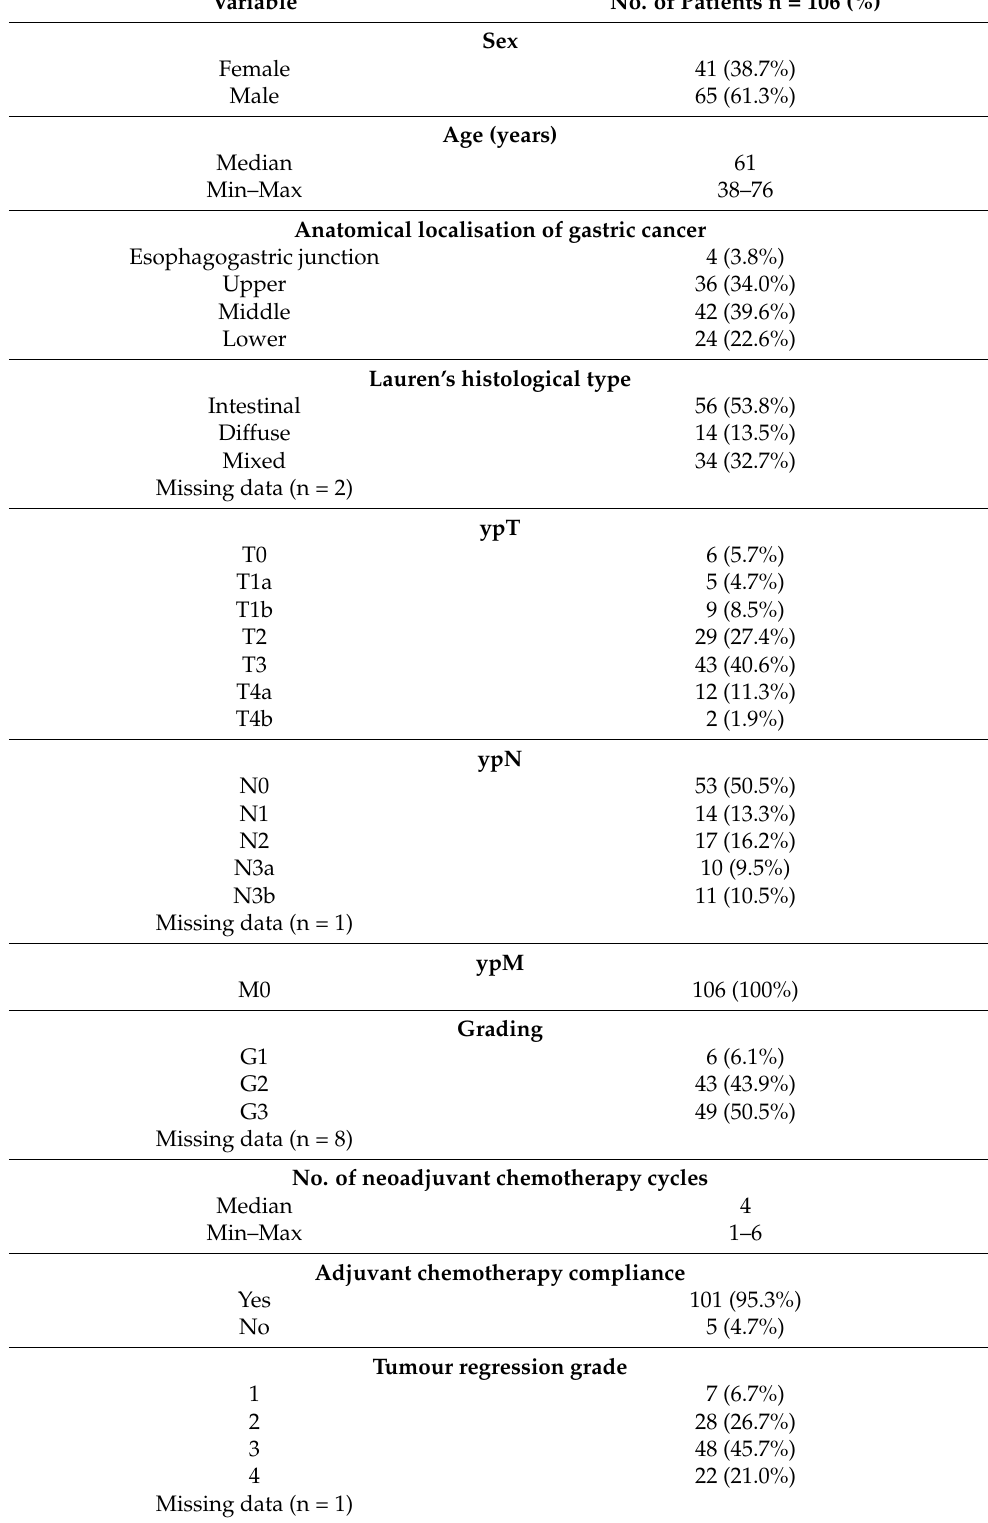
Table 1. Demographic and clinical characteristics of the study